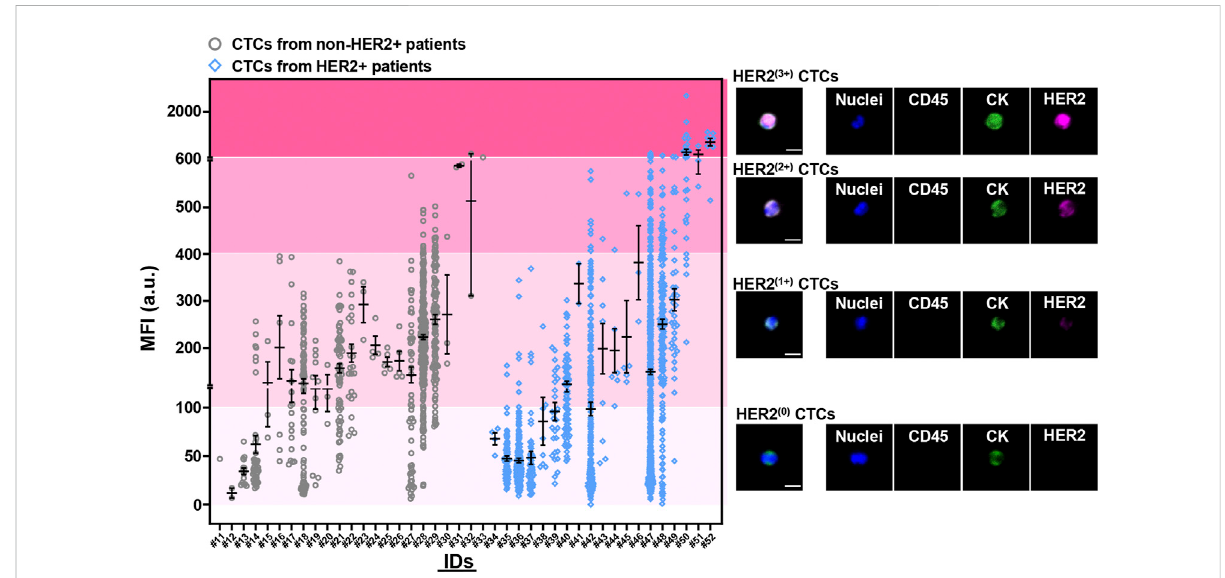
FIGURE 3 Quantitative analysis of HER2 expression on CTCs from breast cancer patients at baseline. Four levels of HER2 expression on CTCs were developed based on fl uorescent quanti fi cation (incl. HER2 (0) CTCs, HER2 (1+) CTCs, HER2 (2+) CTCs, HER2 (3+) CTCs). Left, mean fl uorescent intensities (MFIs) from HER2 immunostaining on enriched CTCs for each patient (#11 – 52) at baseline. Patients who had baseline CTCs were presented as two cohorts, with non-HER2+ tumor (IHC0; IHC+; IHC++ and FISH – ) (gray, #11 – 33; n = 23), or with HER2+ tumor (IHC+++; IHC++ and FISH+) (blue, #34 – 52; n = 19). Data are presented as scattered dots, together with means ± standard error of mean (SEM). x axis, the IDs of patients. HER2 expression on CTCs were quantitatively determined as four MFI ranges from HER2 immunostaining, including no staining/barely perceptible staining (HER2 (0) ; MFI 0 — 100 a.u.), faint staining (HER2 (1+) ; MFI 100 — 400 a.u.), moderate staining (HER2 (2+) ; MFI 400 — 600 a.u.), strong staining (HER2 (3+) ; MFI > 600 a.u.). Right, the representative fl uorescent graphs of the captured CTCs with different levels of HER2 expression. Scale bar: 10 μ